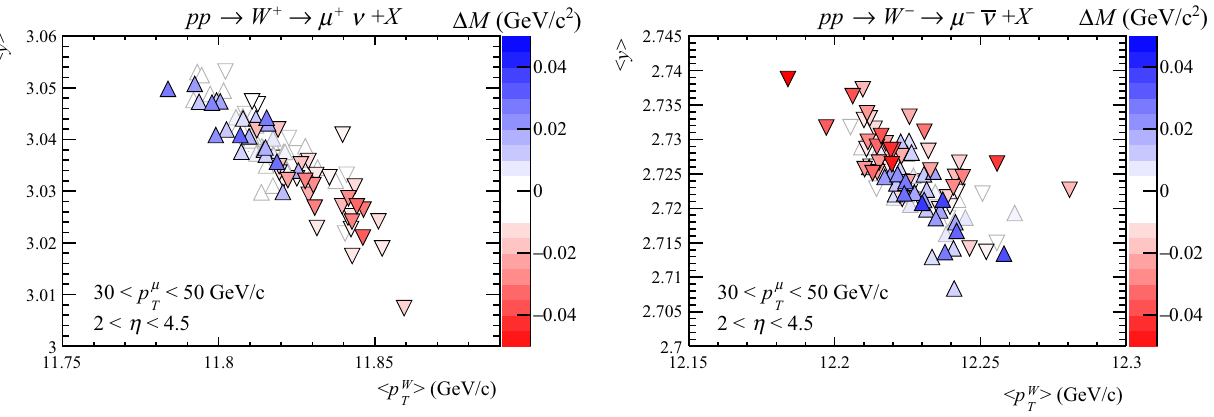
(cid:8) and (cid:7) y (cid:8) for a subset of replicas of Fig. 6 The distributions of (cid:7) p W a single toy dataset. The markers drawn with an up (down) pointing T the NNPDF3.1 set. Each marker is assigned a colour according to the triangle correspond to Δ M values greater (less) than zero μ shift of the M W value determined from a fit to the p distribution of T